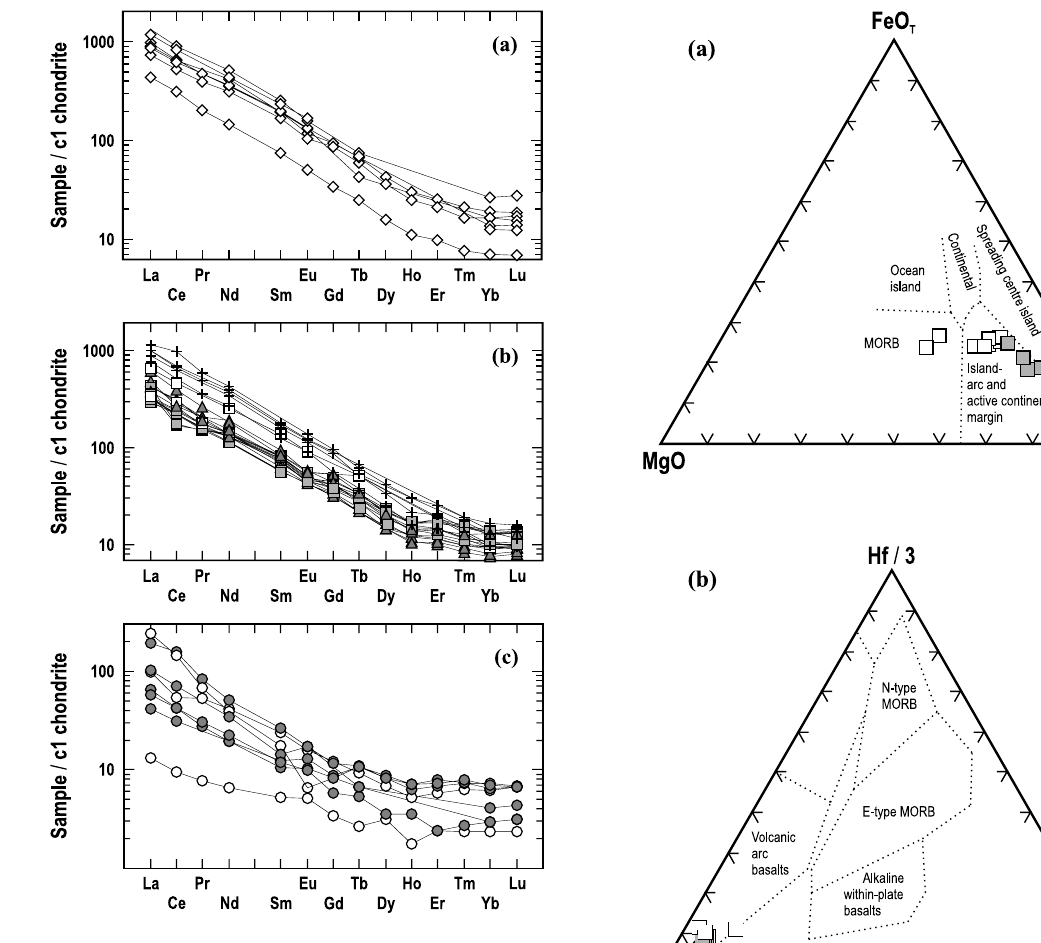
Fig. 7 – REE patterns, normalized against C1 chondrite (Evensen et al. 1978),forPiquiriSyeniteMassifsamples: (a)apatite-bearingpyroxene cumulates,(b)lamprophyricmaficmicrogranularenclavesandsyenitic rocks; (c) ultrapotassic granites. Symbols as in Figure 6.